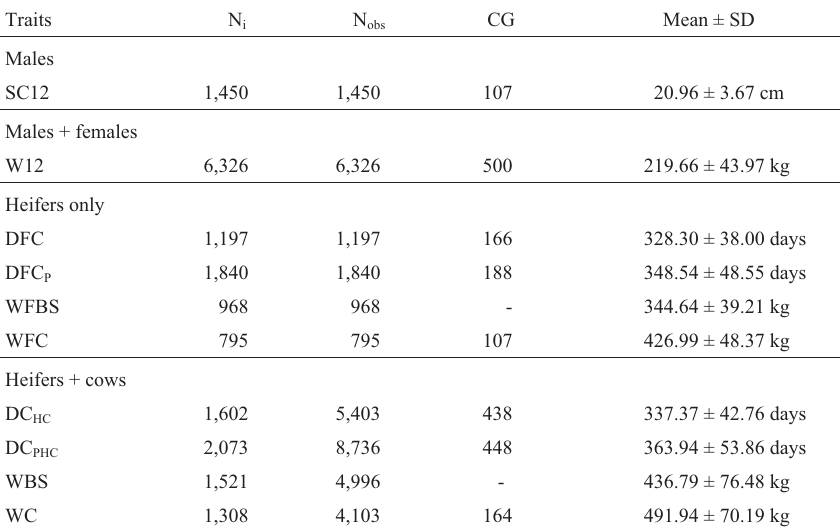
Table 1 - Breeding traits for a Canchim herd. Number of animals (N i ), observations (N obs ) and contemporary groups (CG) plus mean and standard devia- tion (SD) for the following traits: days to first calving without (DFC) and with (DFC P ) penalization of non-calving heifers; days to calving without (DC HC )andwith(DC PHC )penalizationofnon-calvingcows;scrotalcircumferenceat12monthsofage(SC12);weightofmalesandfemalesat12months of age (W12); weight of heifers at the beginning of the first breeding season (WFBS) and at first calving (WFC); weight of cows at the beginning of the breeding season (WBS) and at calving